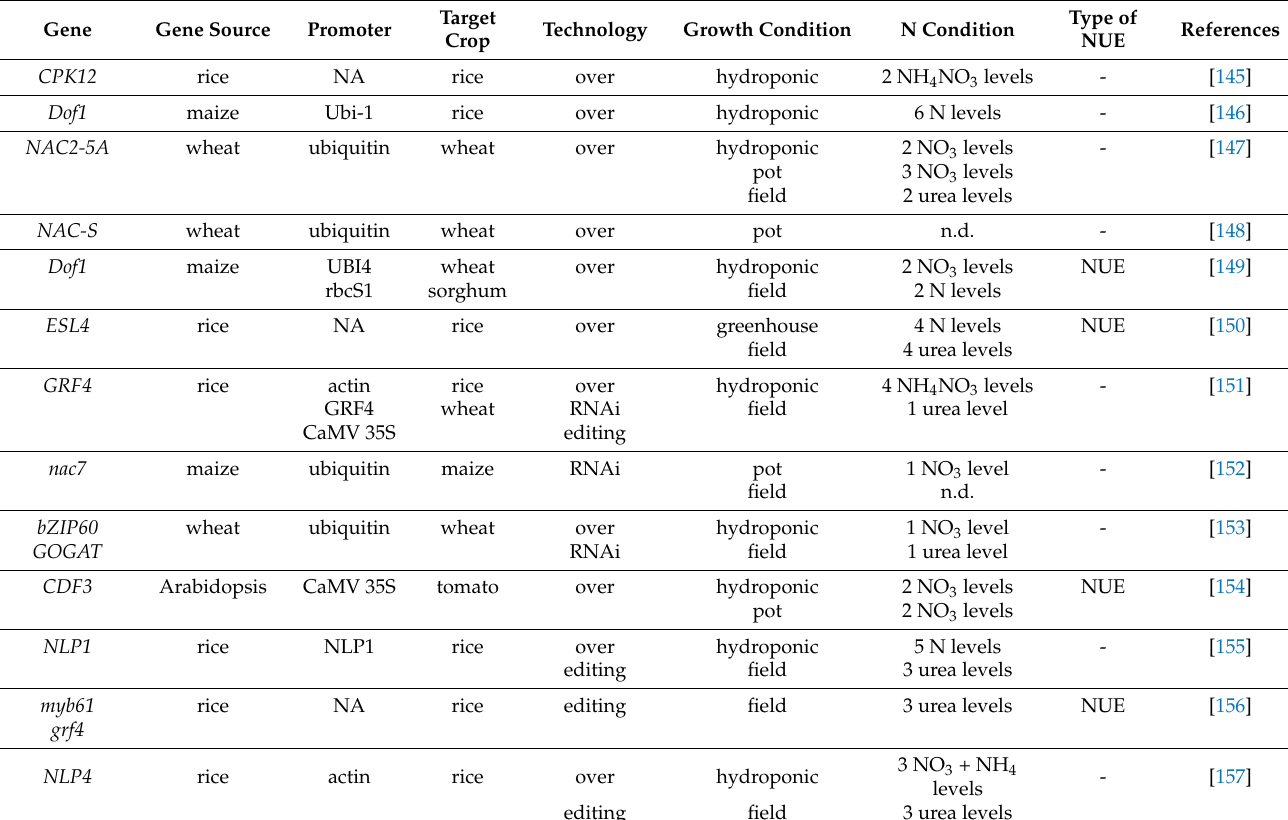
Table 4. Manipulation of transcription factors to improve nitrogen use efficiency in